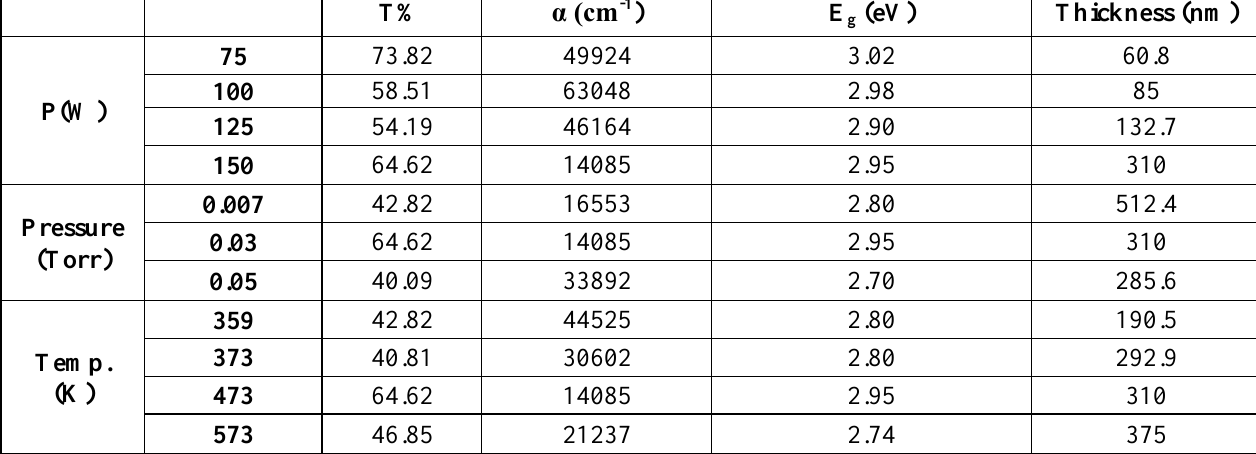
Fig. 2: (αhν) 2 as a function of photon energy of (V power, working pressure and temperature substrate. Table 1: Optical constants (at λ=500 nm) and thickens for (V sputtering power, working pressure and temperature